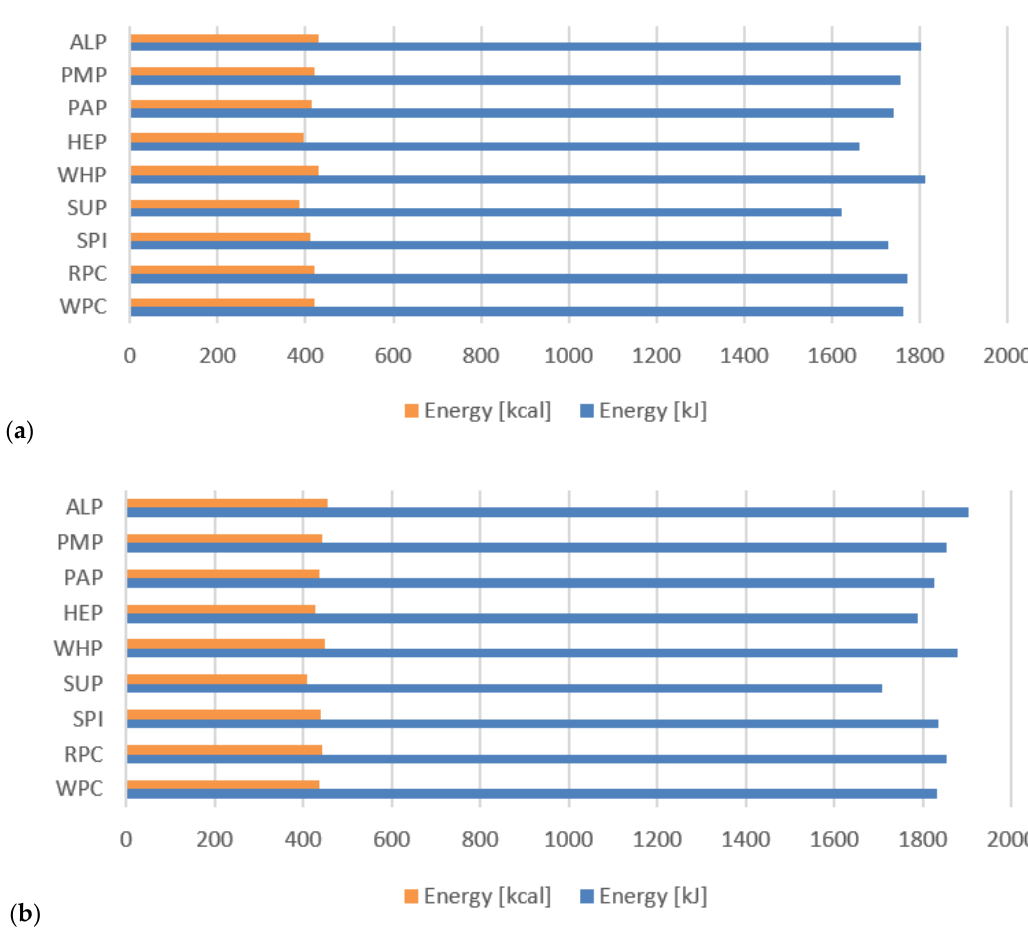
Figure 6. ( a ) Energy value of high-protein bars without chocolate coating; ( b ) With chocolate coating.